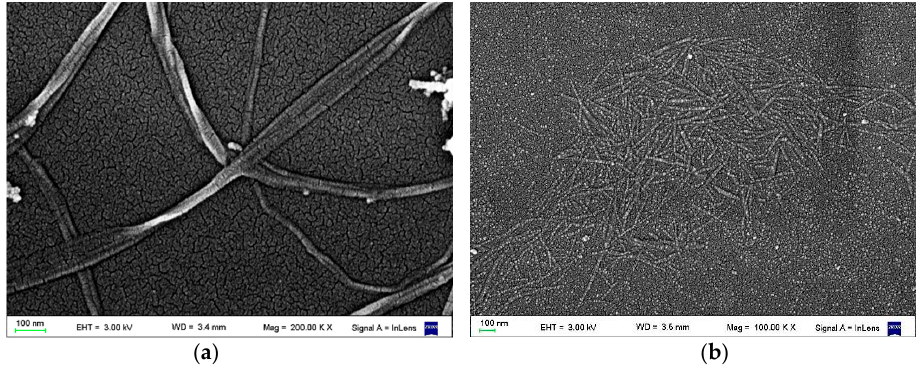
Figure 1. FESEM images of ( a ) CNC and ( b ) BC.